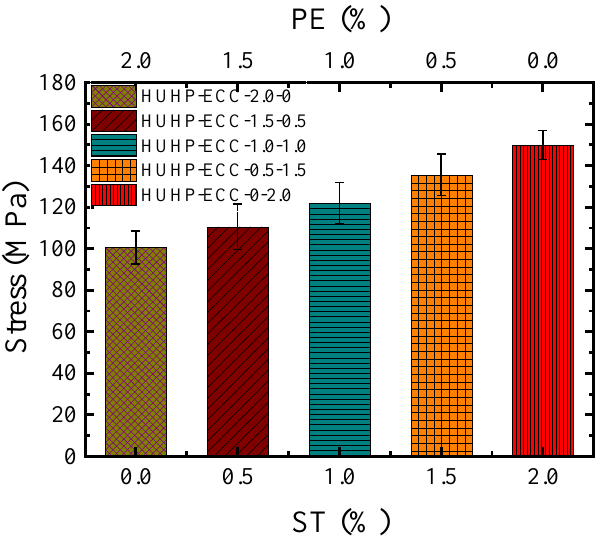
Figure 14. Comparison of compressive strengths of different volume fractions of PE and ST fibers.